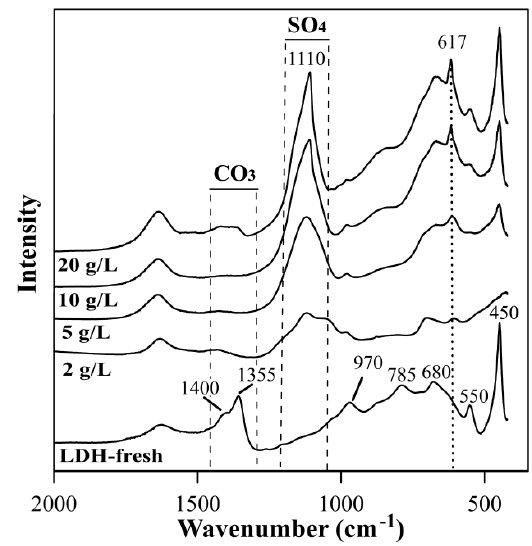
Figure 3. The FTIR spectra of LDH before AMD treatment (LDH-fresh) and LDH after AMD treatment in the function of dosage.